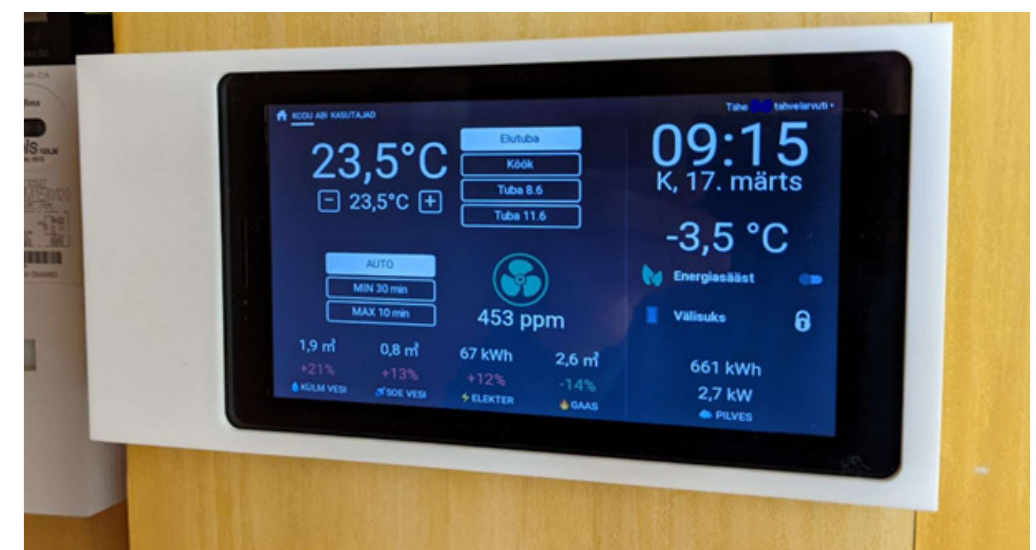
Figure 2. Smart home panel installed in the khrushchyovka‐type apartments, 2021. Source: Courtesy of SmartEnCity project team.